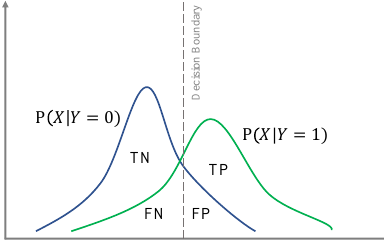
Figure 2. Decision Boundary: impact of the decision boundary on different scenarios of the binary